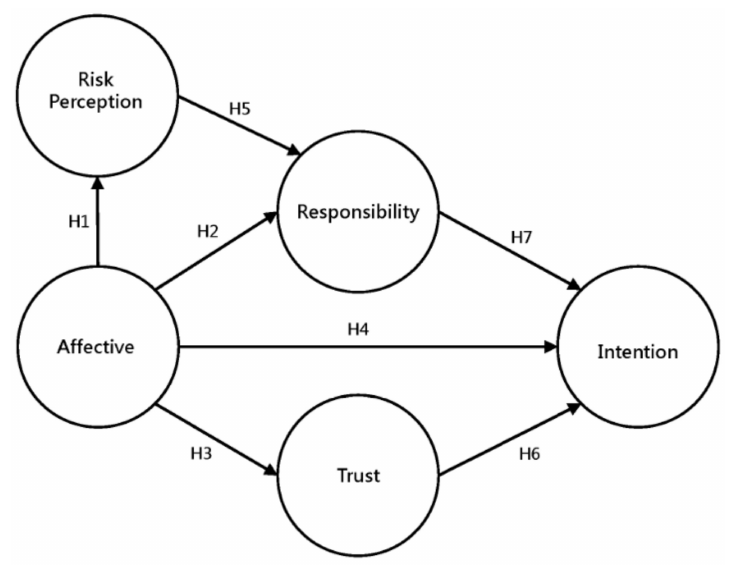
Figure 1. The Framework of MPAM.